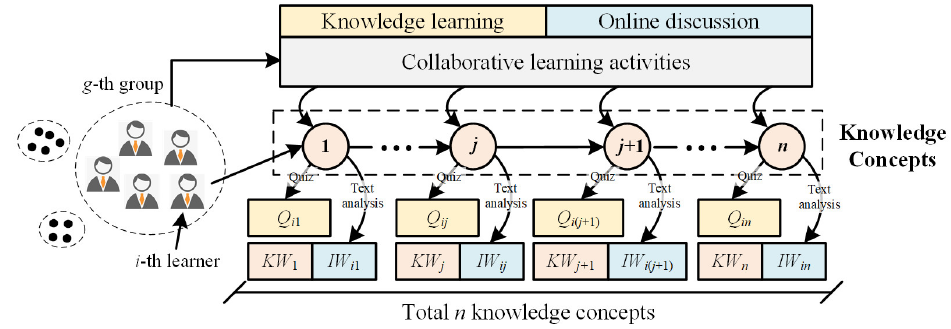
Figure 1. Description of online collaborative learning process.